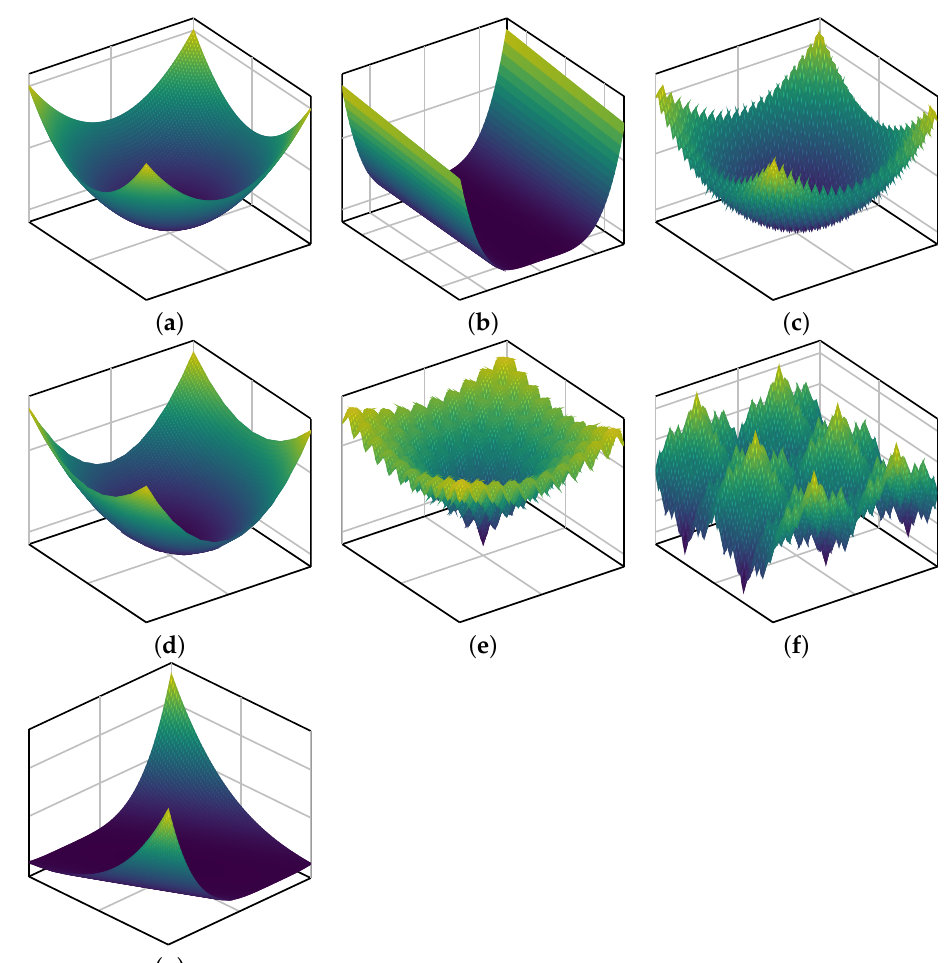
Figure 3. Plot of the functions with two variables. ( a ) Sphere, ( b ) Rosenbrock, ( c ) Rastrigin, ( d ) Griewangk, ( e ) Ackley, ( f ) Weierstrass, ( g )